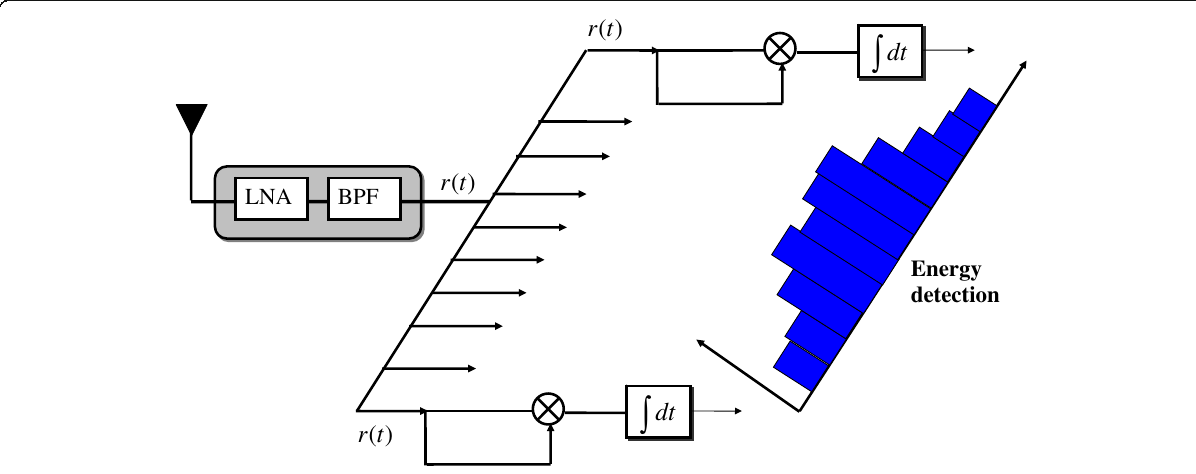
Fig. 5 Block diagram of energy detection receiver for time delay